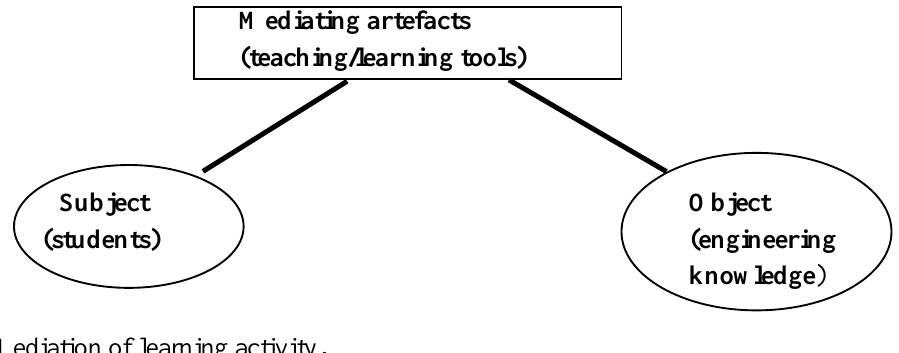
Figure 2. Mediation of learning activity